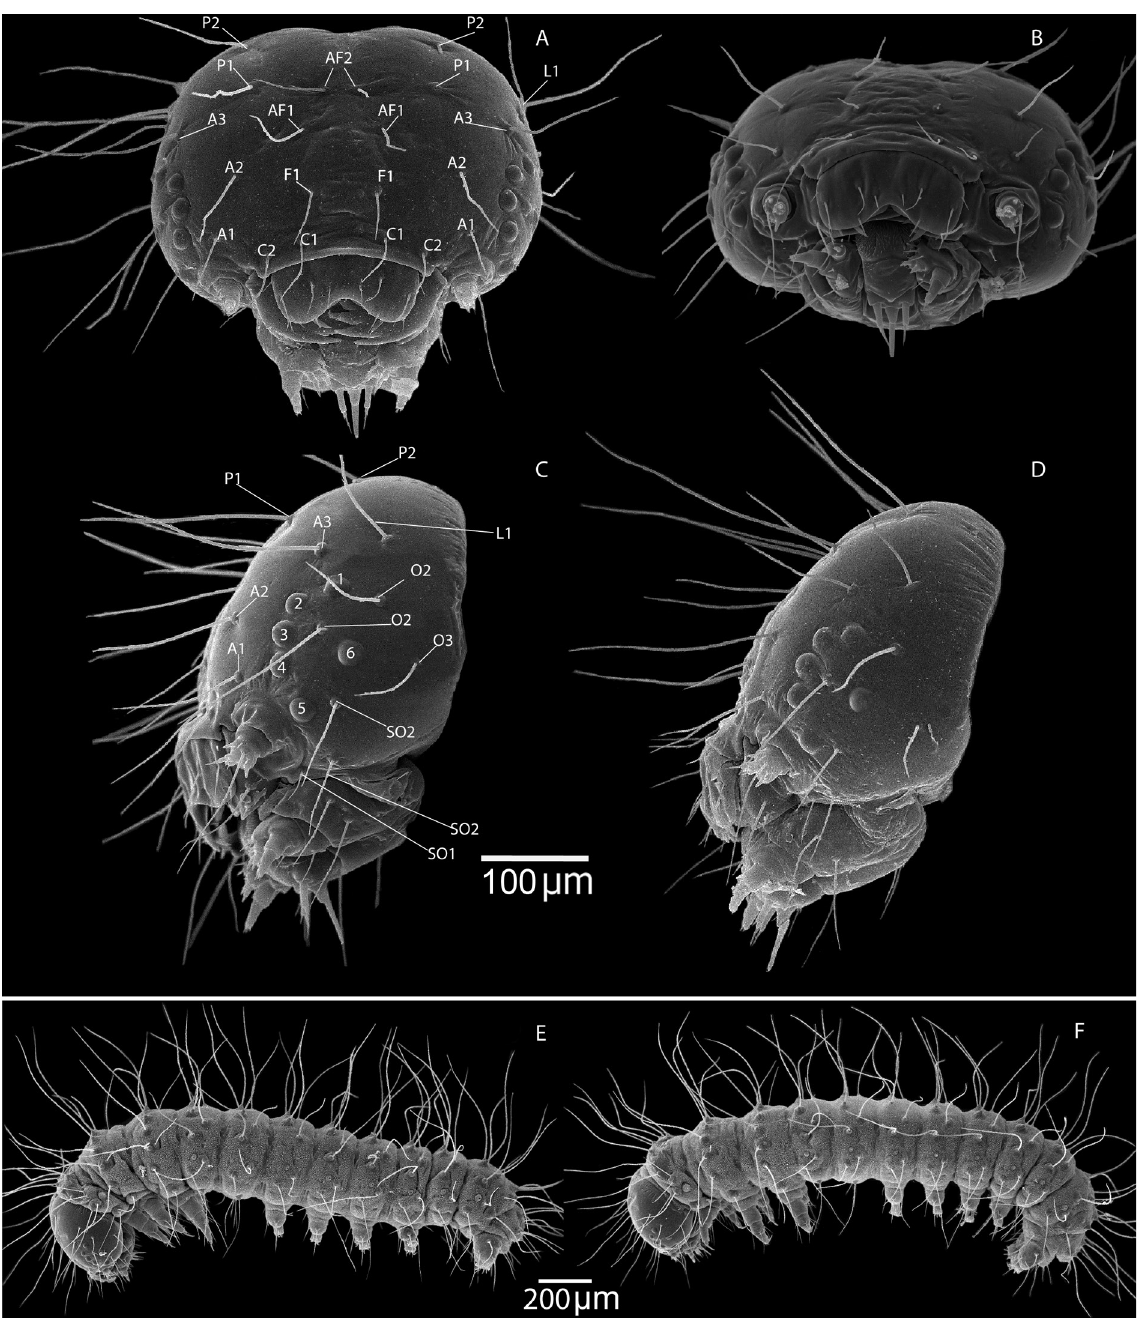
Fig. 24. First instar caterpillar of Melitaea shahvarica sp. nov. A . Head, bottom view. B . Head, front view. C–D . Head, lateral view. E–F . Caterpillar, lateral